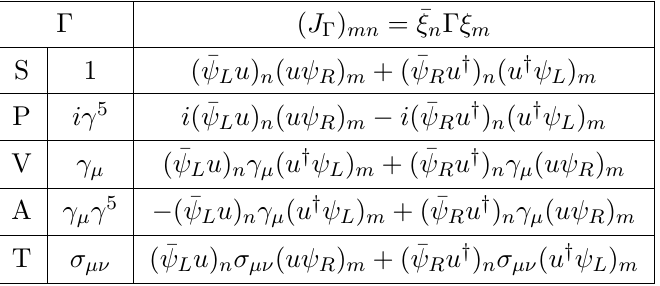
Table 10 . The fermion currents in the two